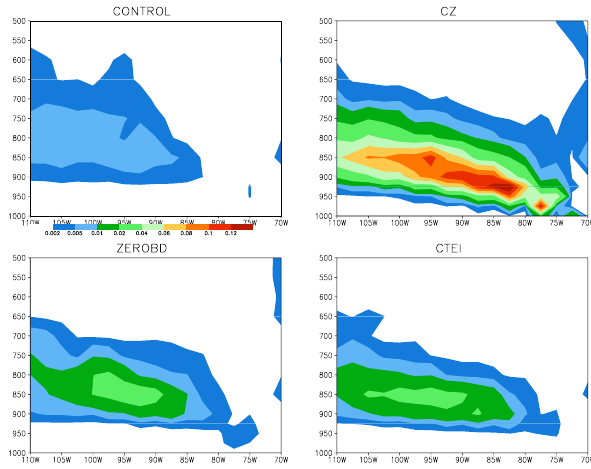
Fig. 2. The ISCCP July mean (1985–1993) total cloudiness in July in the SEP region.